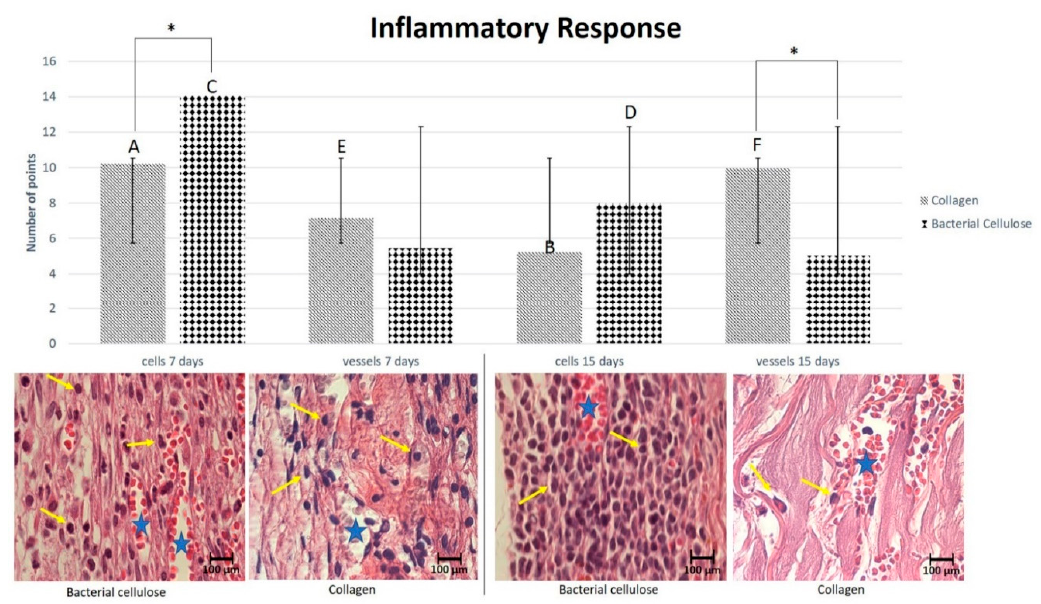
Figure 5. Graph comparing the average numbers of inflammatory cells (yellow arrows) and vessels (blue stars) between the groups and periods analyzed (×100). Regarding the postoperative periods of 7 and 15 days, there was a decrease in the number of inflammatory cells ( p < 0.001) in the BC and BG groups; there was a statistically significant difference in the numbers of vessels between the BG and BC groups ( p < 0.001). (*) denotes intergroup statistical difference; capital letters denote the intragroup statistical difference. In short, for inflammatory cells: BC-7 days > BG-7 days > BC-15 days > BG-15 days ( p < 0.05); for vessels: BG-15 days > BG-7 days > BC-7 days > BC-15 days ( p < 0.05).